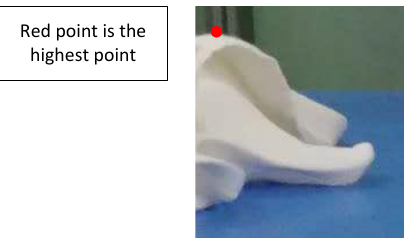
Figure 12. The highest point is on a flat surface below which there is nothing.